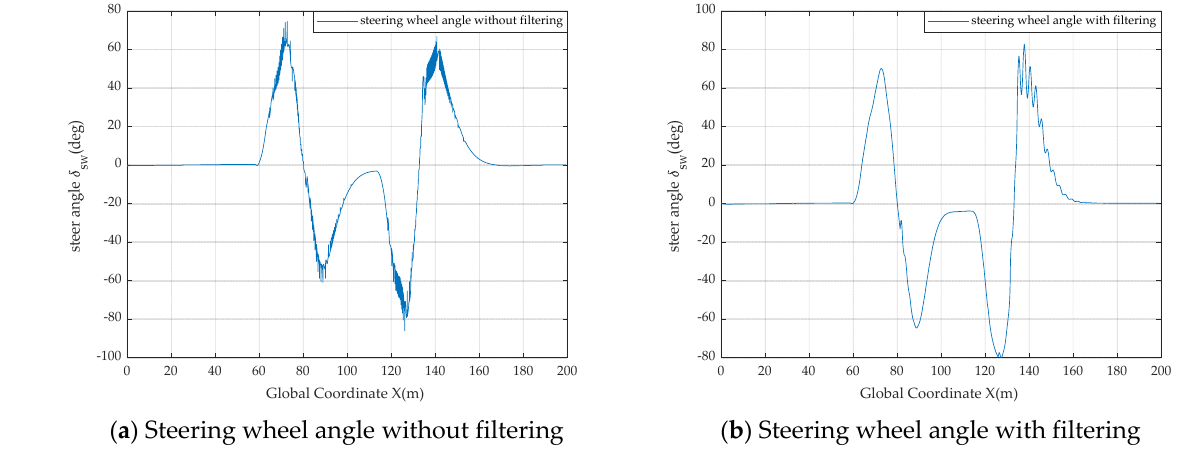
Figure 5. The steering wheel angle with and without filtering at RAC = 0.9 and VS = 10 m/s.